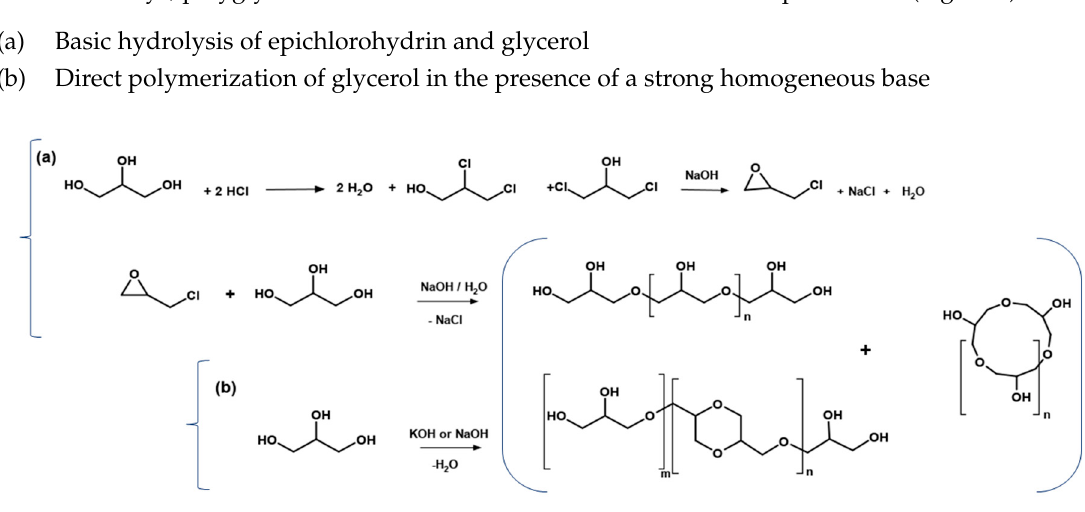
Figure 2. Industrial routes for polyglycerol production: ( a ) Epicerol ® process, with epichlorohydrin from glycerol prior to basic hydrolysis of epichlorohydrin ( n and m = 1–4); and ( b ) direct polymerization of glycerol over an alkaline homogeneous catalyst ( n and m = 2–10) (reproduced from